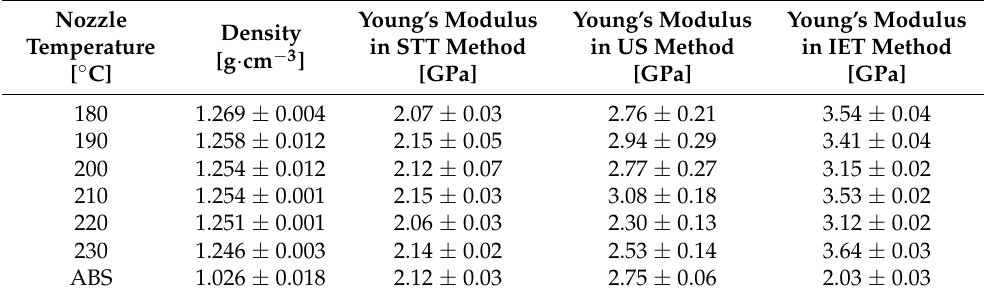
Table 1. Measured density and values of Young’s modulus calculated with the use of the compared methods for samples printed at all nozzle temperatures, with standard deviation